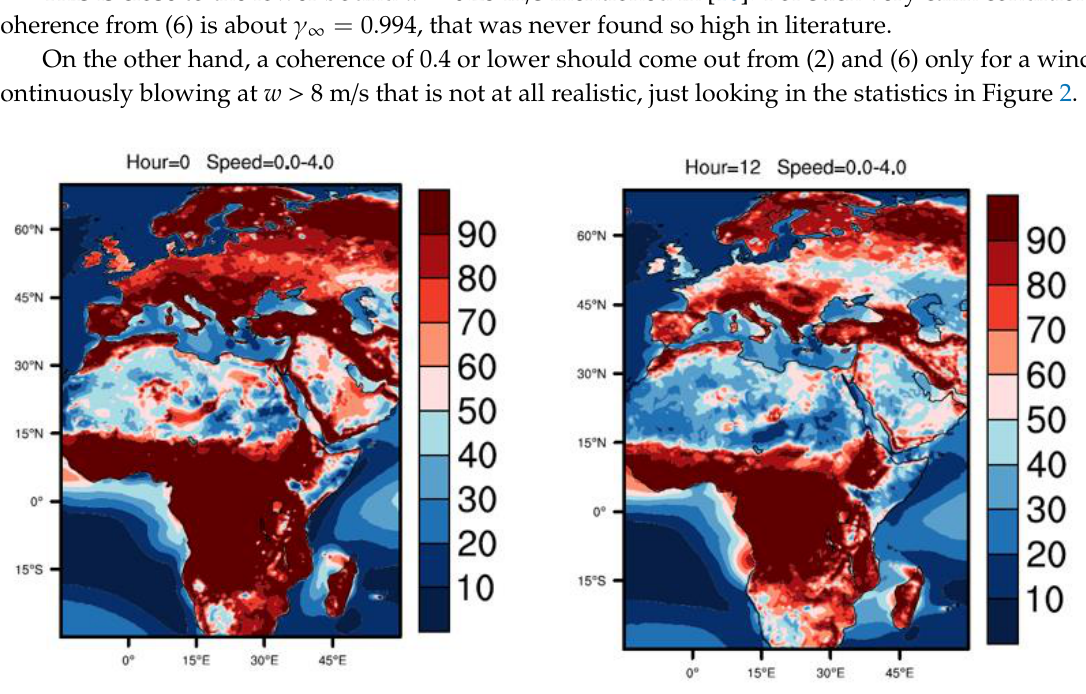
Figure 2. Probability of the surface wind speed ≤ 4 m/s at hour 0 (left) and 12 (right), from ERA-5 (all data from 1989 to 2018). Courtesy of Yongjun Zheng, Jean-Christophe Calvet, METEO-FRANCE, CNRM (Centre National de Recherches Météorologiques). Notice that in forested areas wind speed over 4 m/s occurs for less than 10% of the time.